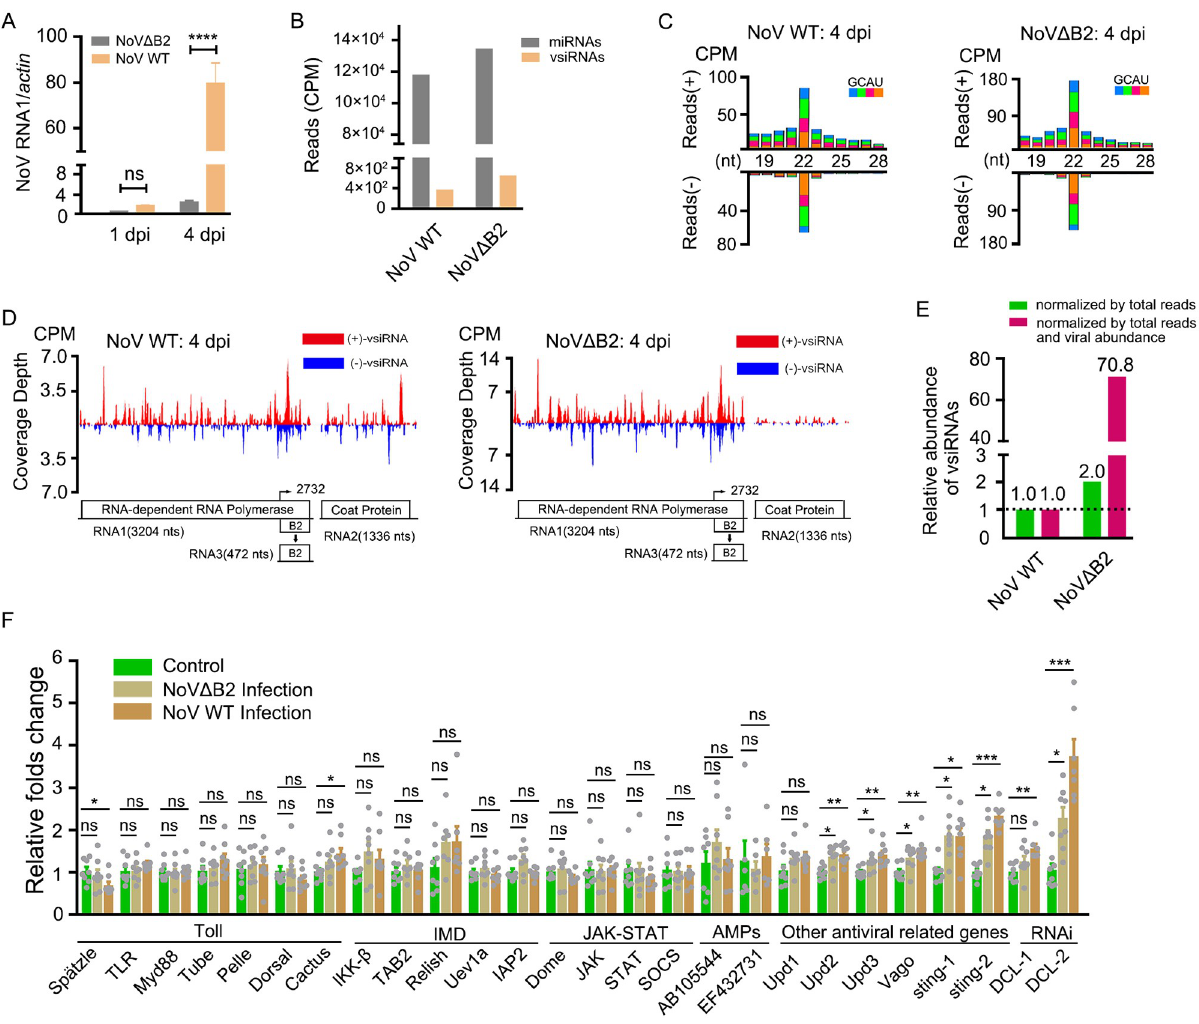
Fig 4. Production of abundant vsiRNAs in H . longicornis ticks infected by NoV through injection. (A) Viral RNA1 accumulation from ticks infected NoV WT or NoV Δ B2 by microinjection at 1dpi and 4dpi was determined by RT-qPCR. (B) Reads of mature miRNAs and vsiRNAs from the small RNA-seq libraries of NoV WT or NoV Δ B2-infected ticks at 4 dpi. (C) Size distribution of virus-derived small RNAs sequenced from ticks infected with NoV WT or NoV Δ B2 at 4 dpi. (D) Genomic coverage depth of 21- to 23-nt vsiRNAs sequenced from NoV-infected or NoV Δ B2-infected ticks. (E) Relative abundance comparison of 21- to 23-nt vsiRNAs sequenced from ticks infected with NoV WT or NoV Δ B2 at 4 dpi. Read counts are normalized either by total 21- to 23-nt reads only (green bar) or by both total 21- to 23-nt reads and viral relative accumulation determined by RT-qPCR (red bar). (F) Relative folds change of immune related genes expression levels with NoV WT or NoV Δ B2 infection at 4 dpi in H . longicornis ticks. For RT-qPCR analyses of viral accumulation, the viral RNA levels were calculated by Δ Ct method and tick β -actin mRNA was used as the internal reference. For RT- qPCR analyses of innate immunity-related gene expression levels, ΔΔ Ct method was used. The data represent mean ± SEM values of three biological replicates (10 nymphs per biological replicate) for viral accumulation detection and 8 biological replicates for gene expression level (3 nymphs per biological replicate). Significance was determined by ANOVA with Dunn’s tests. ns: not significant, � P < 0.05, �� P < 0.01, ��� P < 0.001. Read counts are shown as per million total 18- to 28-nt reads (CPM), and the 5’ terminal nucleotide of virus-derived small RNAs is indicated by different colors. Genomic coverage depth is indicated by the position of its 5’ terminal nucleotide. Sense strand-vsiRNAs are depicted in red, and antisense strand- vsiRNAs are depicted in blue. A schematic diagram representing the organization of NoV is presented.